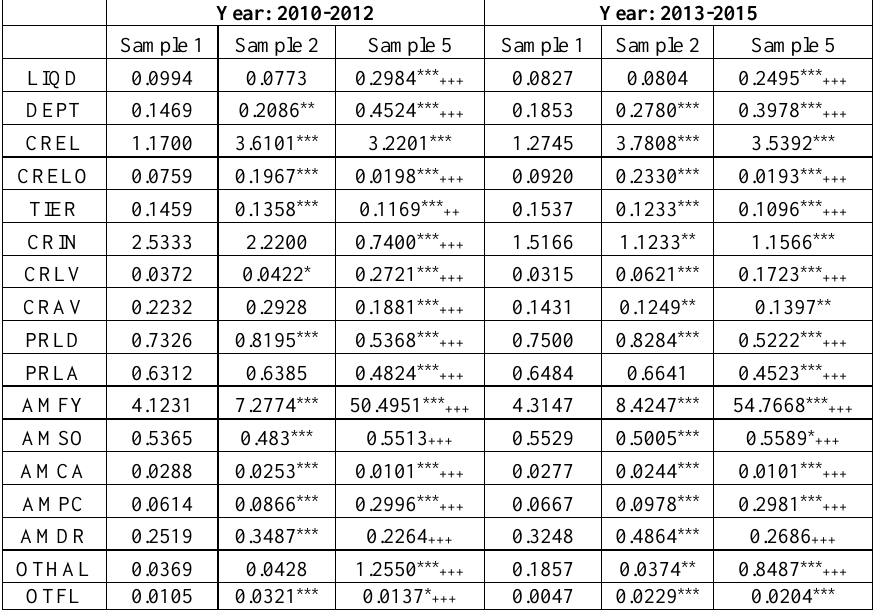
Table 4. Wilcoxon test of sample group variables from 2010 to